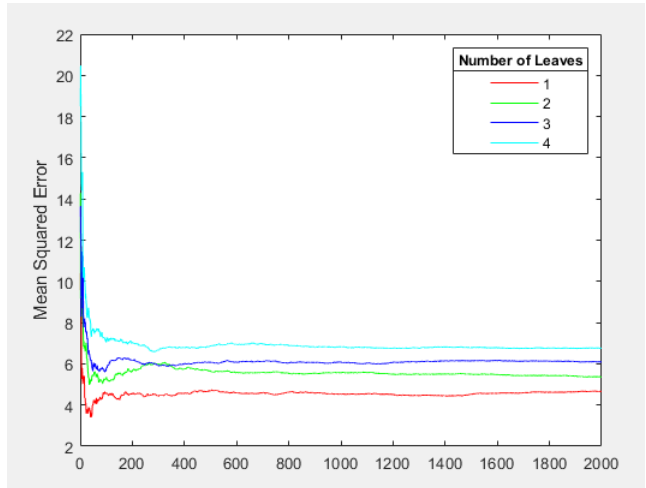
Figure 12. Number of decision trees and